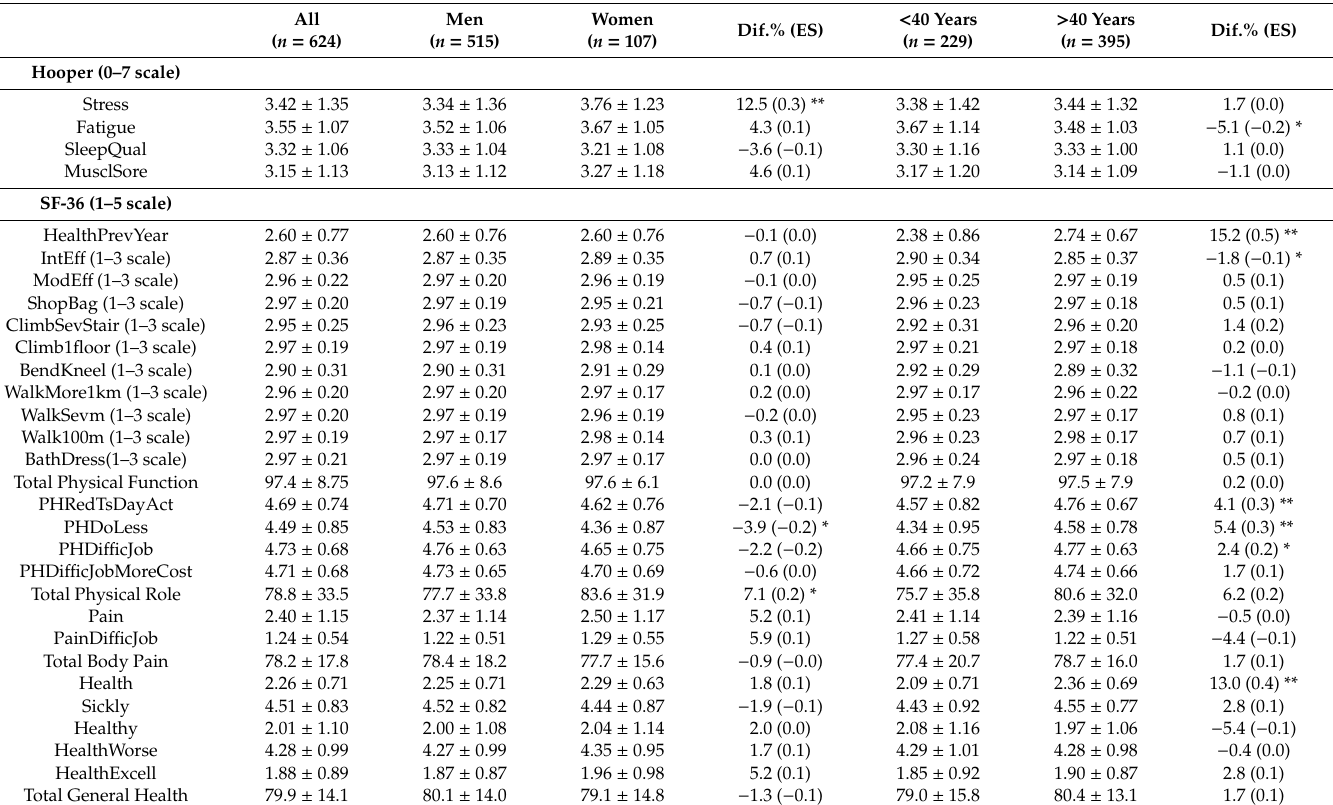
Table 2. Results obtained for the Hooper Index and for the physical dimension of the SF-36 questionnaire obtained by the amateur half-marathon runners participating in the study and based on the sex and age of the participants ( < 40 and > 40